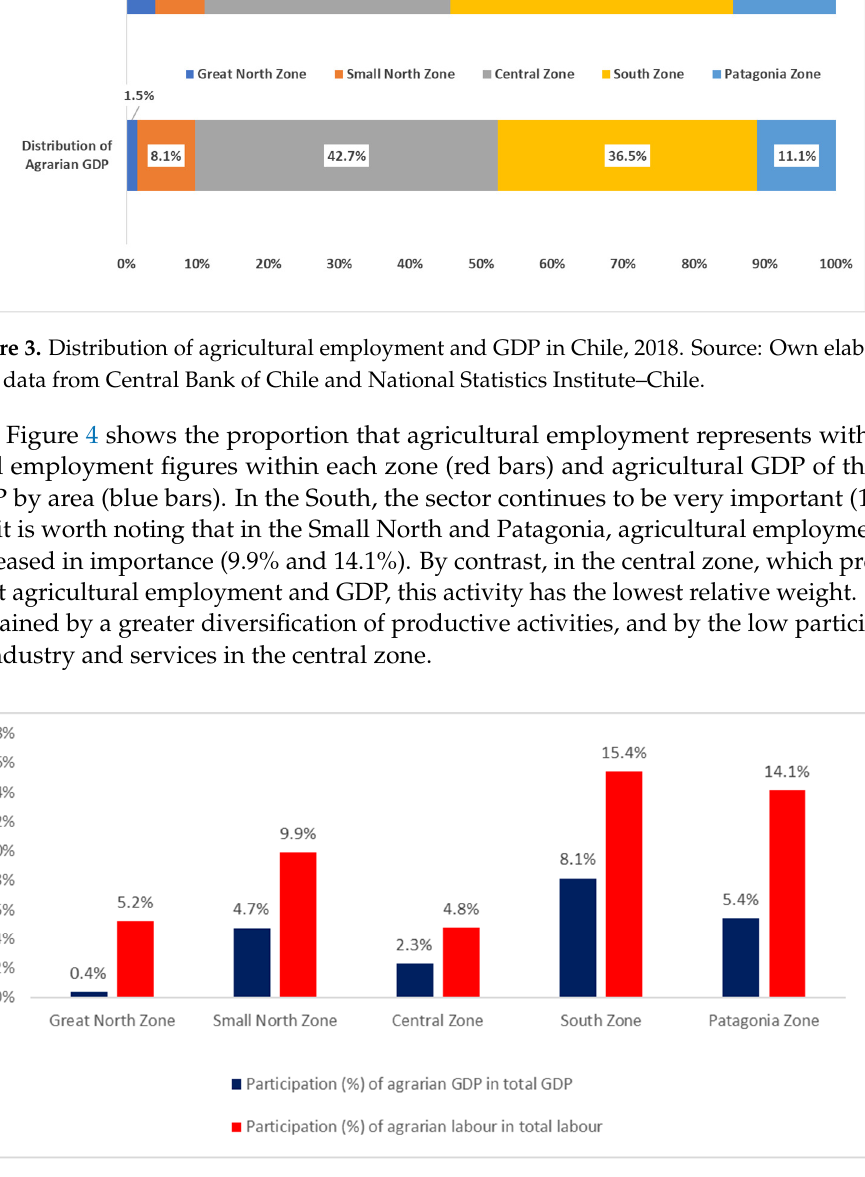
Figure 4. Share of agricultural employment and GPD in total activities by zone. Source: Own elaboration with data from Central Bank of Chile and National Statistics